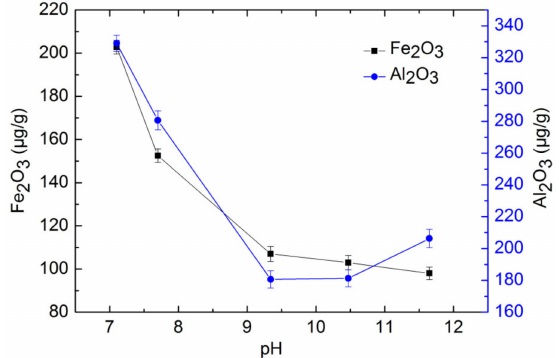
Figure 7. Effect of pH on the removal of impurities in